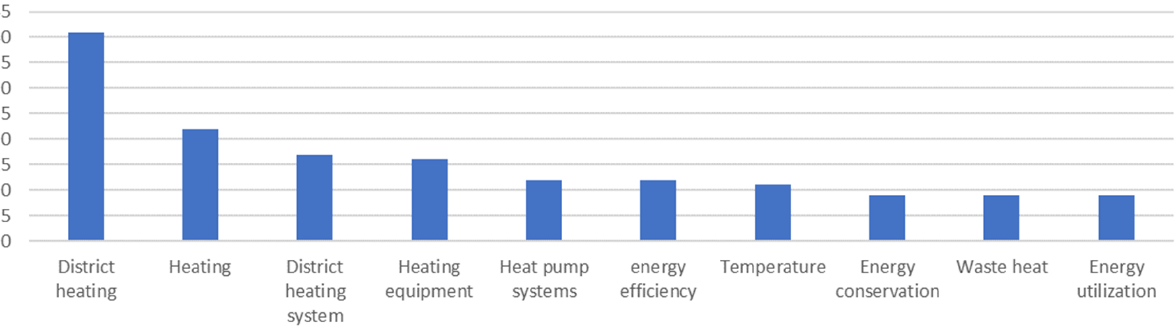
Figure 10. Transfer—most frequent keywords (horizontal axis) and the number of articles (vertical axis).